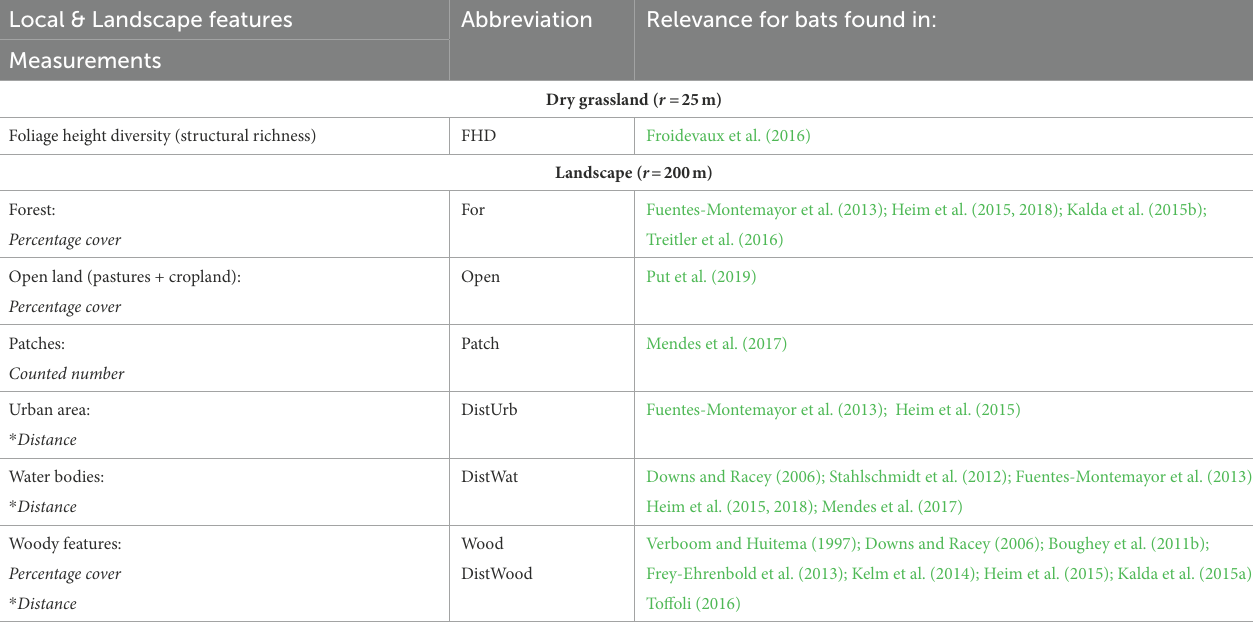
TABLE 1 Final choice of local and landscape features and their abbreviations used for further analysis. Local & Landscape